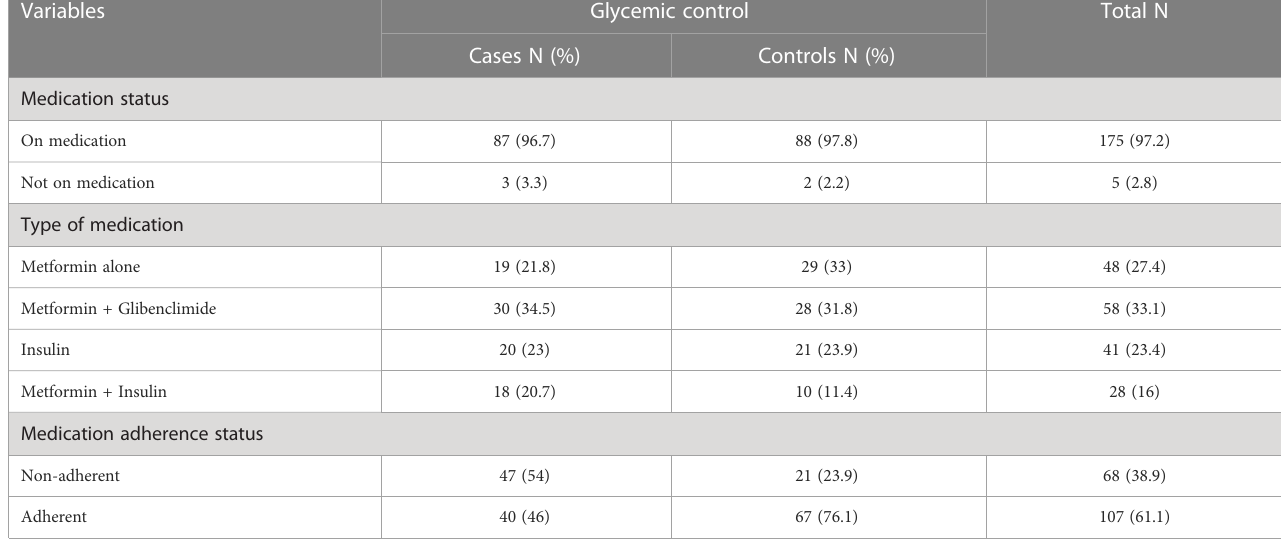
TABLE 4 Medication-related characteristics of type 2 diabetes mellitus patients at DM clinic of UoGCSH, Northwest Ethiopia, 2020 (N=180). Variables Glycemic